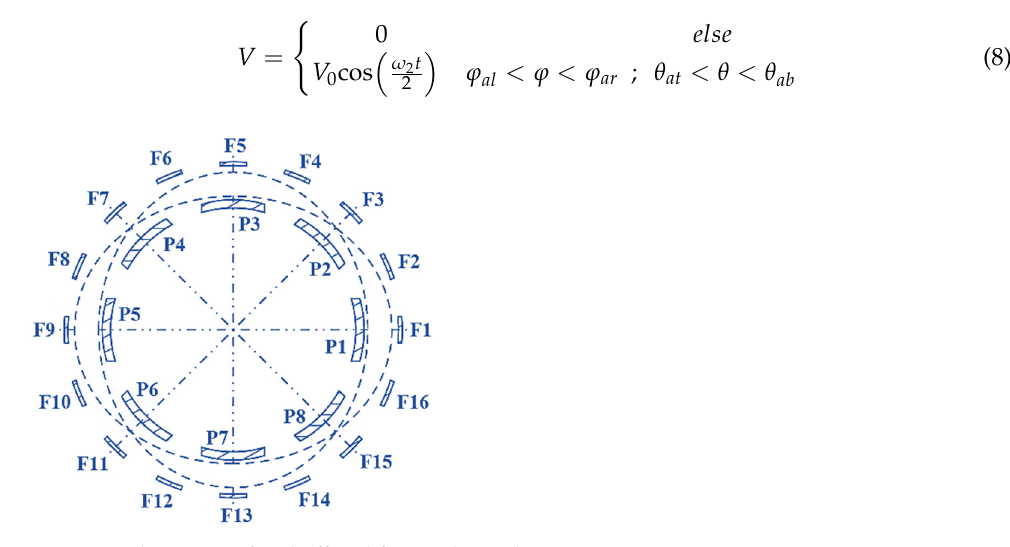
Figure 5. Placement of pickoff and forcer electrodes. Table 2. Position of pickoffs on HRG.